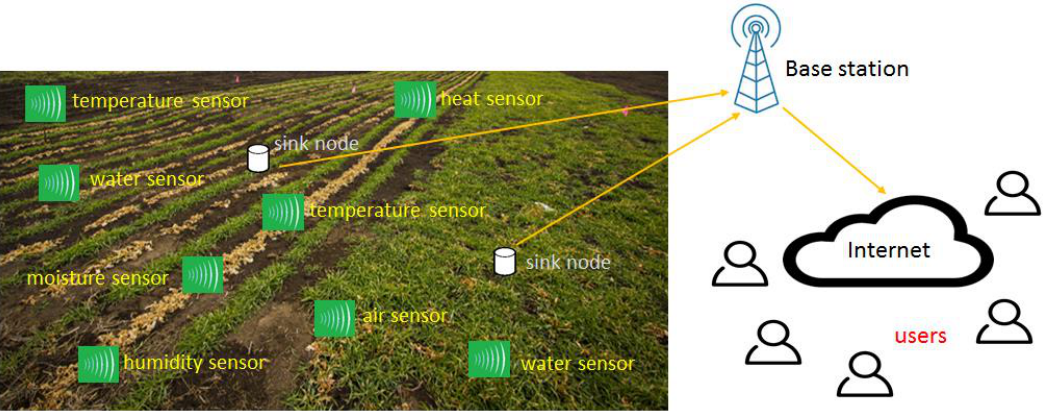
Figure 1. Smart agricultural environment based on wireless sensor network (WSN).